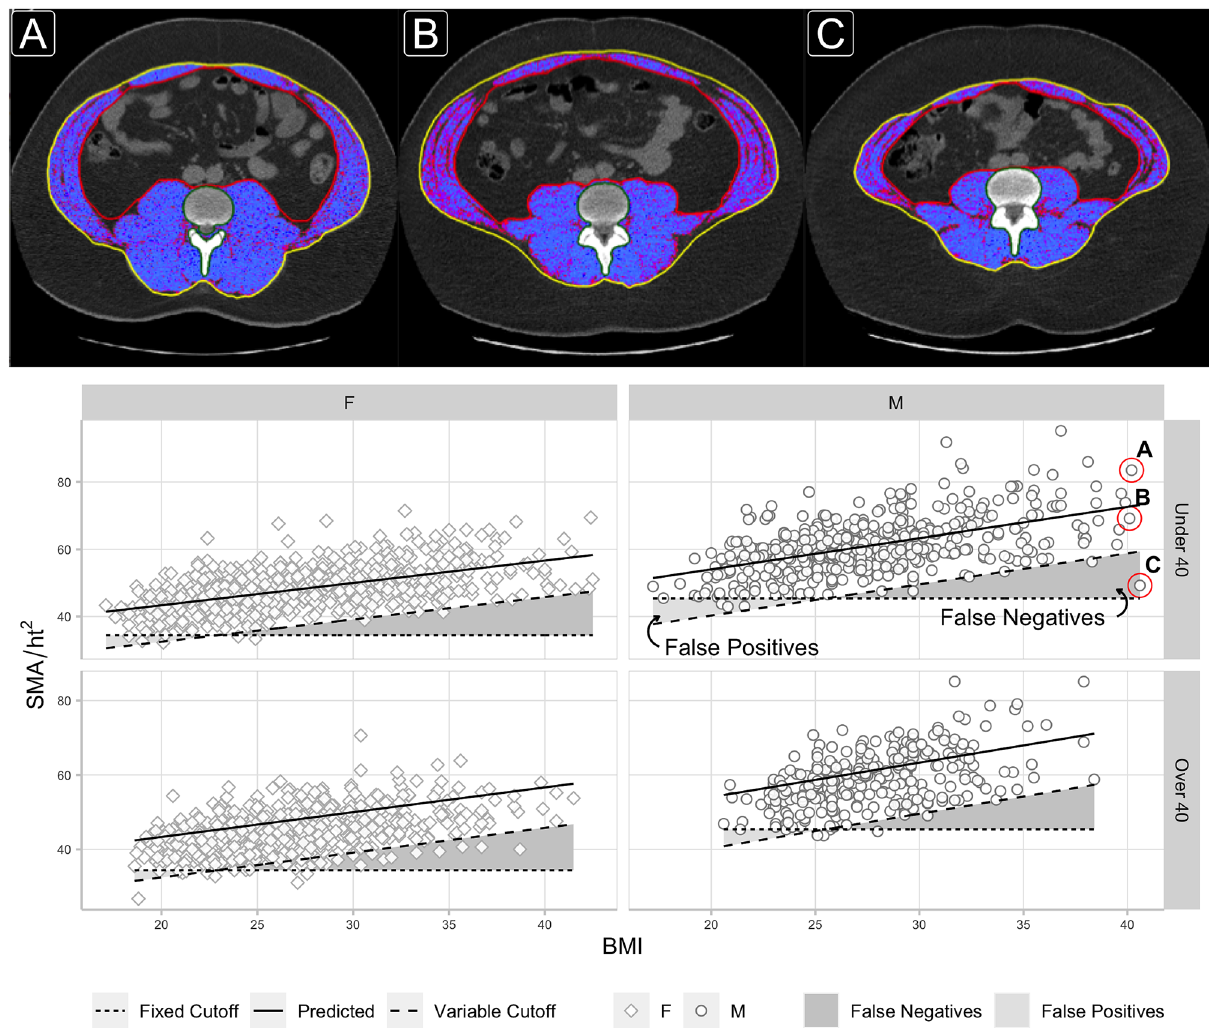
Figure 3. L3 axial CT images highlighting skeletal muscle area for three males of similar age (28–29) and BMI 40.1–40.6, but different z ( SMA HT 2 ) scores (A = 1.56, B = − 0.51, C = − 3.47) are compared. The third individual (C) has a muscle area more than 3 s.d. below the mean value expected for a BMI of 40. He would be classified as not sarcopenic using the fixed cutoff, but would be sarcopenic using the variable (z-score) cutoff. Scatter plots show L3 skeletal muscle area divided by height-squared ( SMA HT 2 ) versus BMI, split by sex and cohort. Lines overlaid for (1) the mean value predicted by our linear regression model (solid line), (2) previously reported (Derstine, 2018) 15 sarcopenia ‘fixed cutoff’ values (dotted line), and (3) bmi-adjusted ‘variable cutoff’ values (dashed line) computed as two s.d. below the predicted mean. Regions of ‘False Positives’ and ‘False Negatives’ sarcopenia diagnosis are shown based on the difference between the ‘fixed’ and ‘variable’